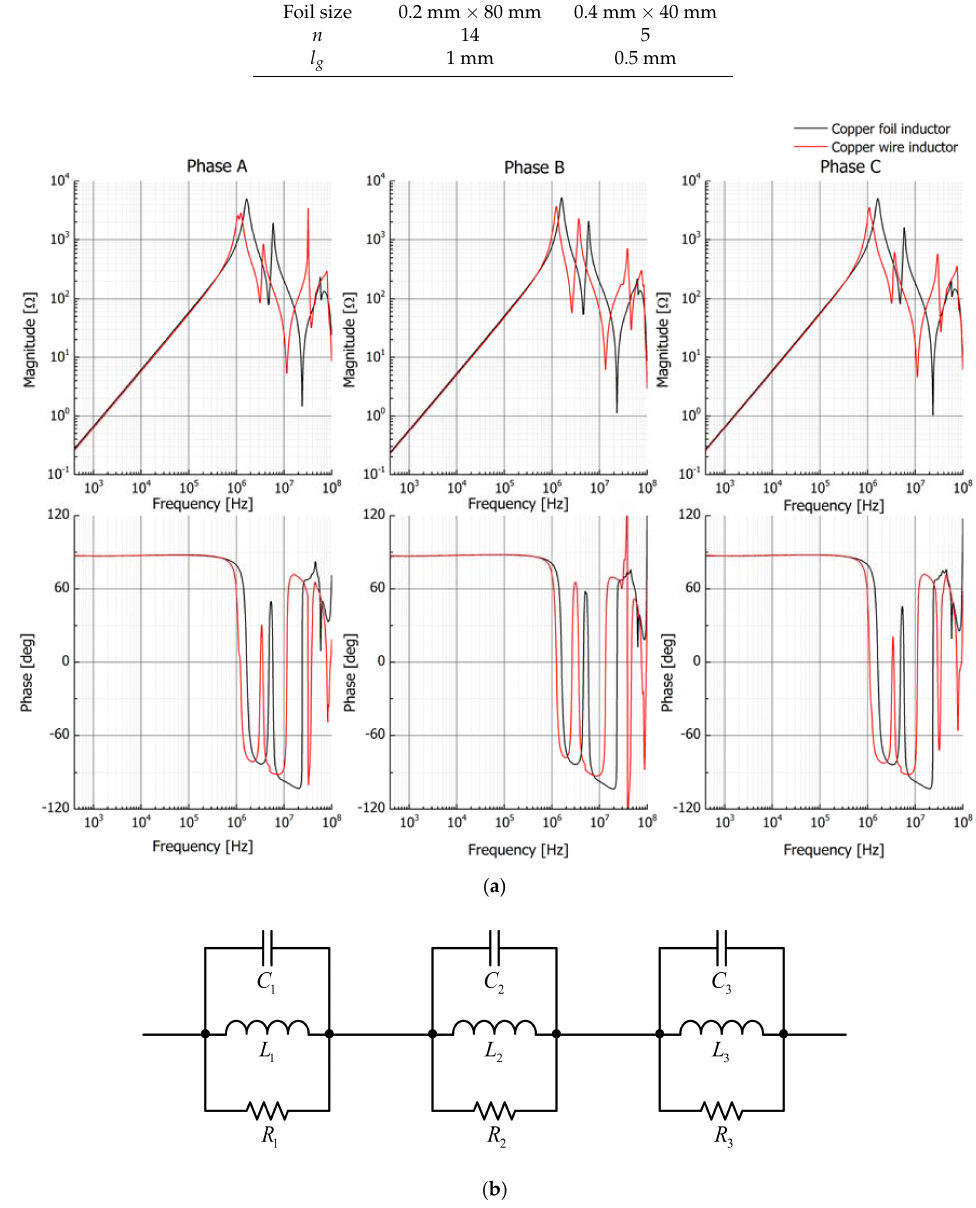
Figure 7. ( a ) Impedance of three phases in the two types of inductors; ( b ) high frequency equivalent circuit of the